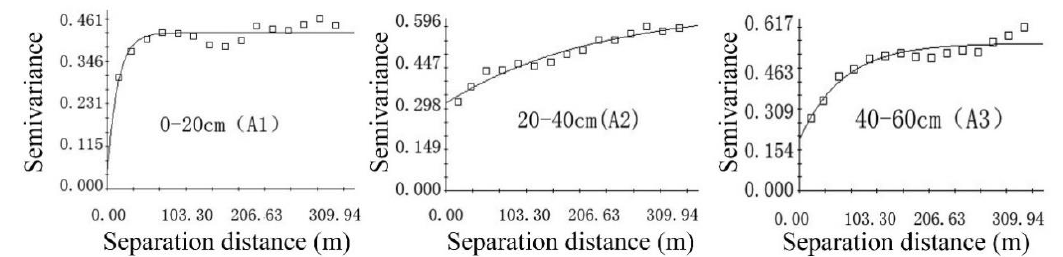
Figure 3. Semi-variogram function theoretical model of soil iron at different depths. Table 2. Geostatistical parameters of soil iron at different depths.